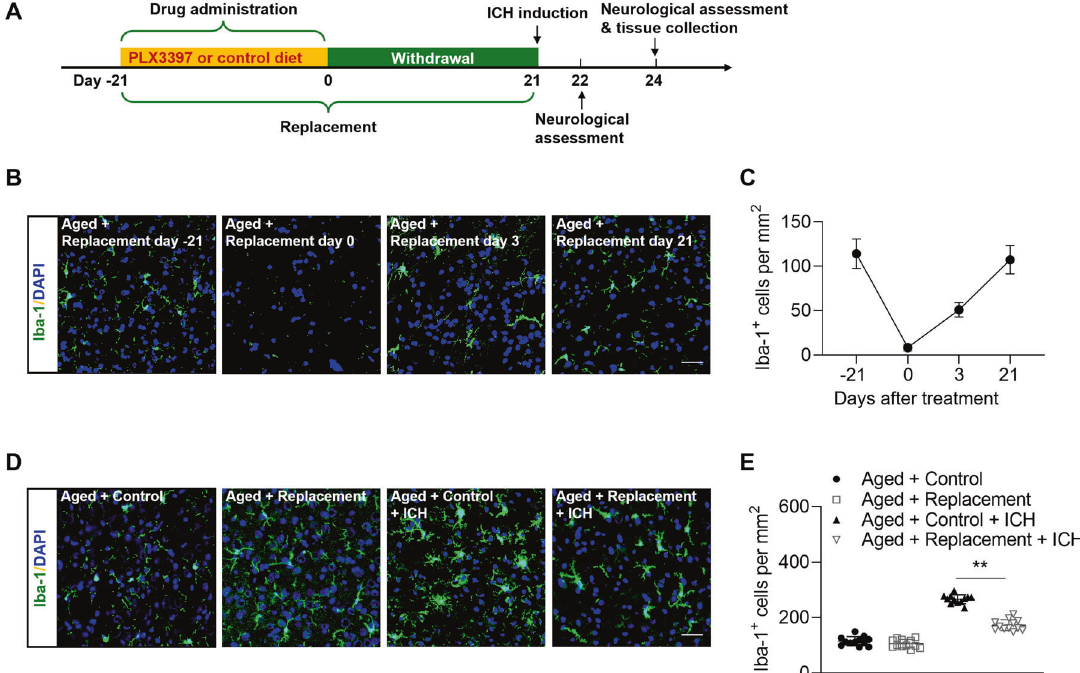
Fig. 1 Microglial replacement in the aged brain. Groups of aged mice received 21 days of PLX3397 treatment in chow or a control diet, and then followed by three weeks of withdrawal prior to ICH induction. ICH induction, neurological assessment and tissue collection were conducted at indicated time points. A Flow chart illustrates drug administration and experimental design. B Brain sections from groups of aged mice receiving PLX3397 in chow at indicated time points after treatment or withdrawal were stained with Iba-1 (green). Nuclei were stained with DAPI (blue). Scale bar: 50 µm. C Counts of Iba-1 + cells in indicated groups of mice. n = 8 per group. D Brain sections from groups of aged mice receiving indicated treatments were stained with Iba-1 (green). Nuclei were stained with DAPI (blue). Scale bar: 50 µm. E